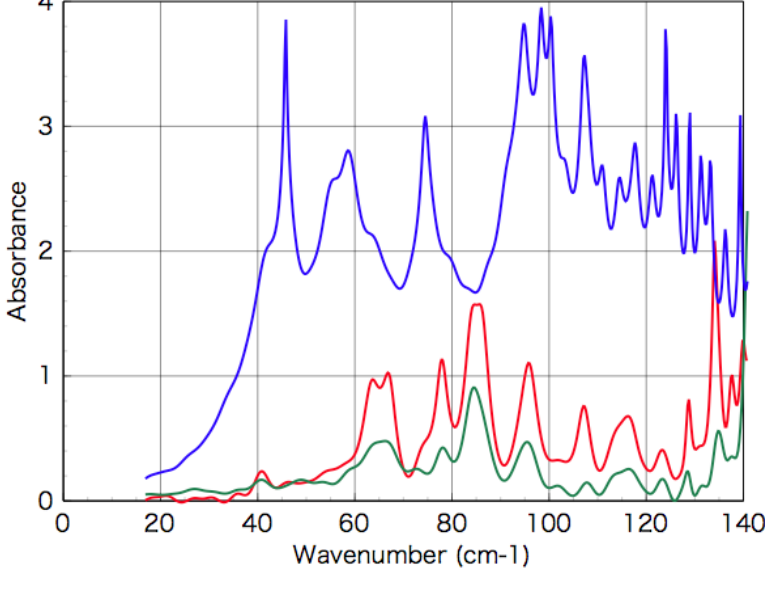
Figure 16. Terahertz absorption spectra of D - (green) and L - (red) and DL -isovaline